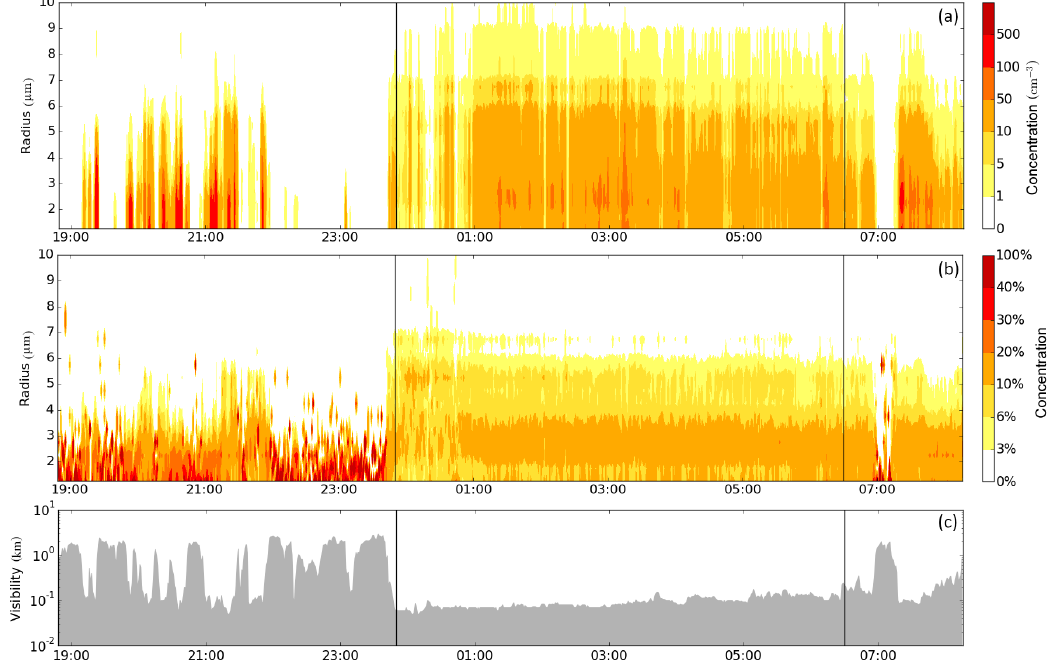
Figure 4. Temporal evolution of the collected data during Fog Event 3: ( a ) absolute drop counts ( b ) relative drop counts ( c ) visibility. Vertical lines mark stage